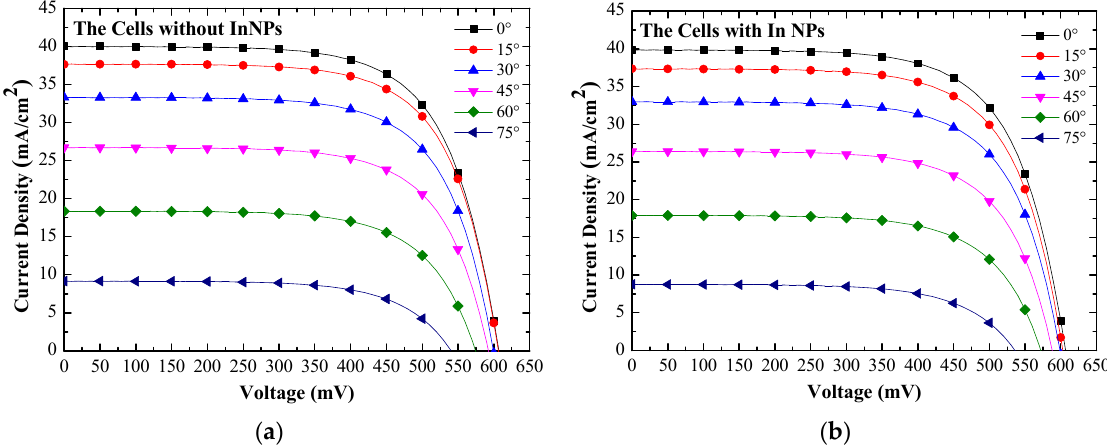
Figure 11. Photovoltaic J-V curves of ( a ) reference silicon solar cell (textured but without NPs) and ( b ) textured silicon solar cell coated with In NPs measured under an AOI of 0°–75°.